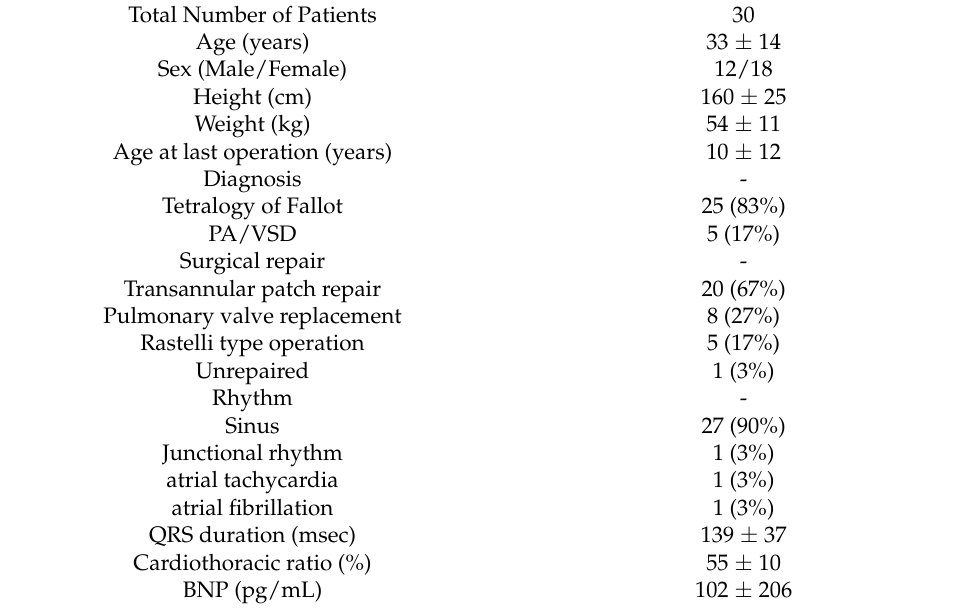
Table 1. Patient